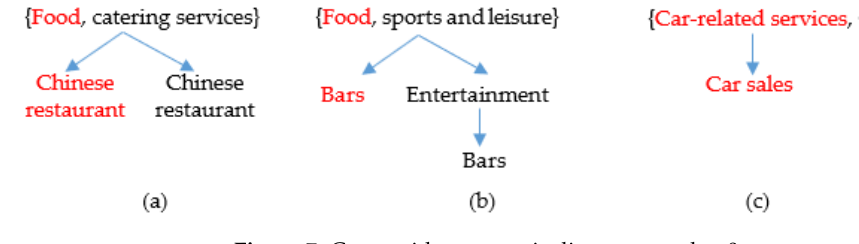
Figure 7. Cases with a semantic distance equal to 0.